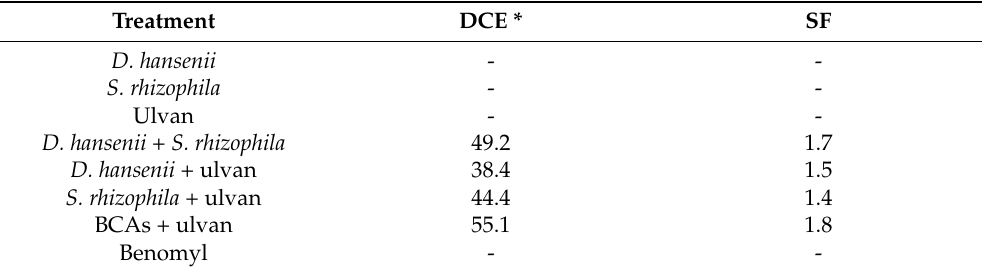
The disease control was calculated by comparing the treatments with the control ( F. proliferatum + sterile dis- tilled water) and was presented as percentage for each treatment. * DCE: Expected effect or expected control percentage, SF: Synergy factor, more information on materials and methods. BCAs: Biological control agents ( D. hansenii + S. rhizophila